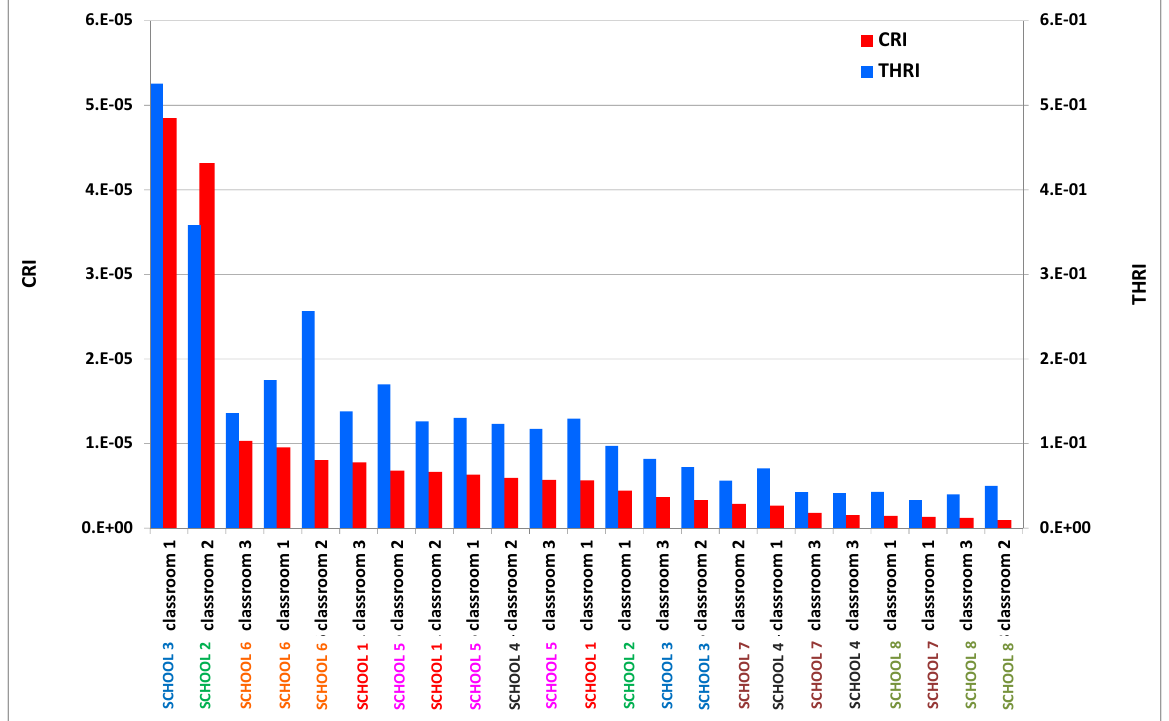
Figure 10. Ranking of monitored sites according to two indicators based on health risk